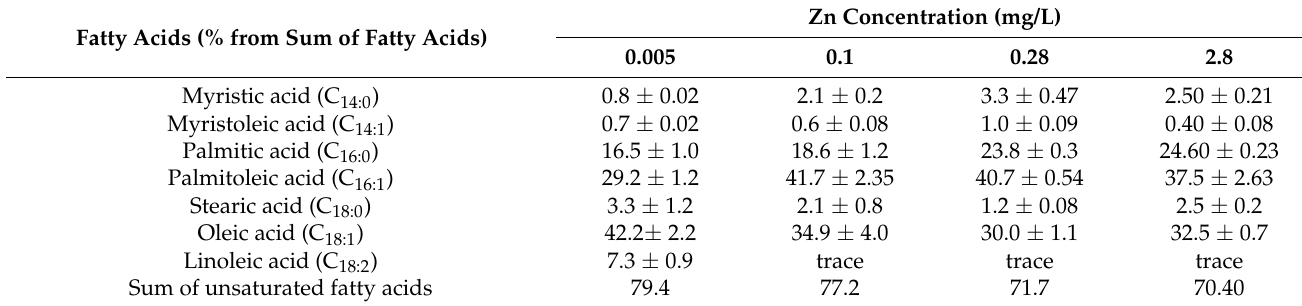
Table 2. The effect of zinc on fatty acid composition.